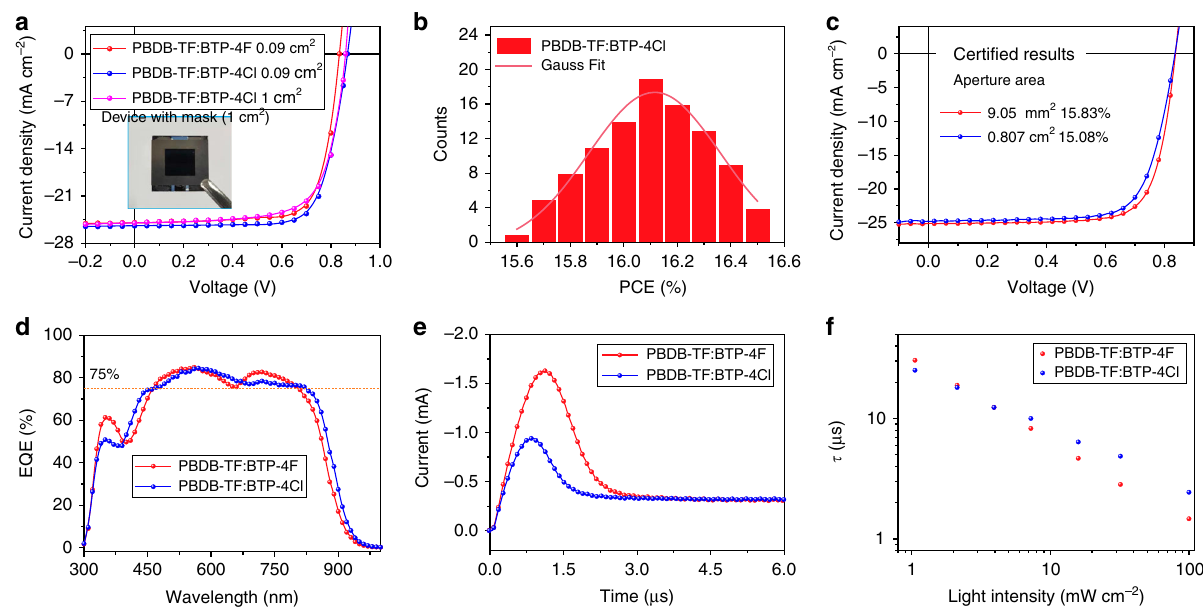
Fig. 2 Device performance. a J − V curves of the PBDB-TF:IT-4X-based devices. b Statistical diagram of PCEs for 100 PBDB-T:BTP-4Cl-based cells. c J − V curves of the devices measured by the NIM, China. d EQE curves of the PBDB-TF:BTP-4X blend cells. e Photo-CELIV curves of the devices for carrier mobility calculations. f Carrier lifetimes under varied light intensities obtained from TPV measurements